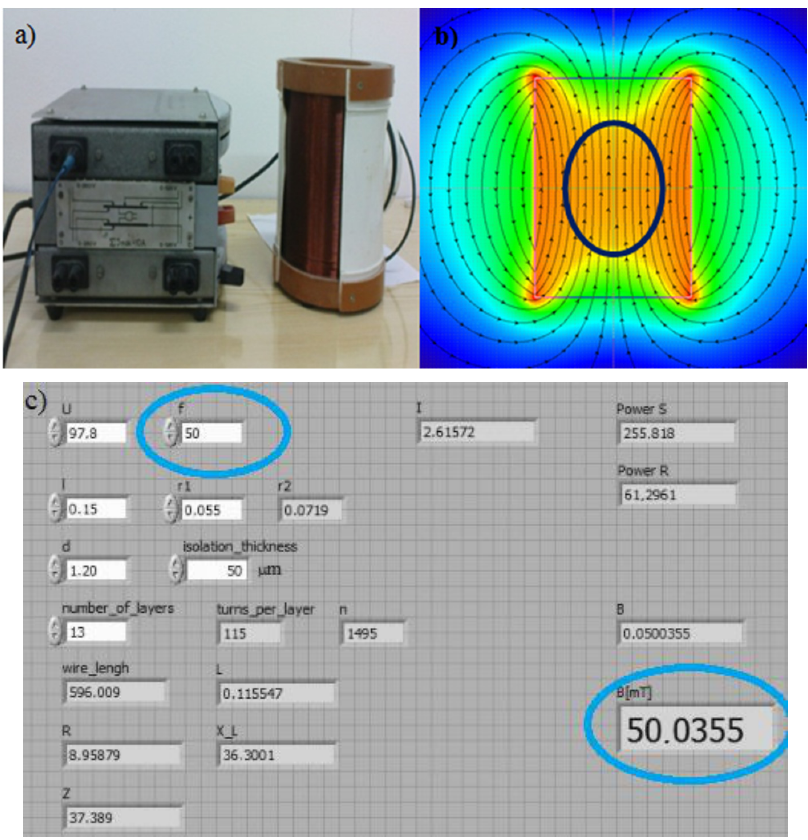
Figure 1. ( a ) Station for performing stimulation with a slowly-changing, low-frequency 50 mT magnetic field. ( b ) Model distribution of magnetic field in the applied solenoid. ( c ) Counter circuit parameters at the proposed induction of a magnetic field (f-frequency, B-induction).